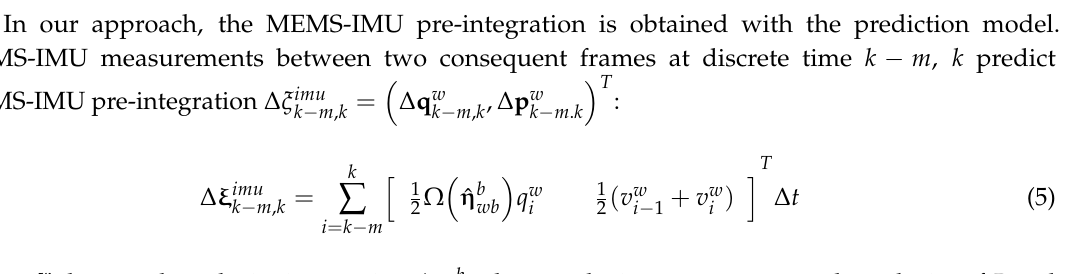
Figure 5. An illustration of predicting searching region with pre-integrating measurements of MEMS-IMU.